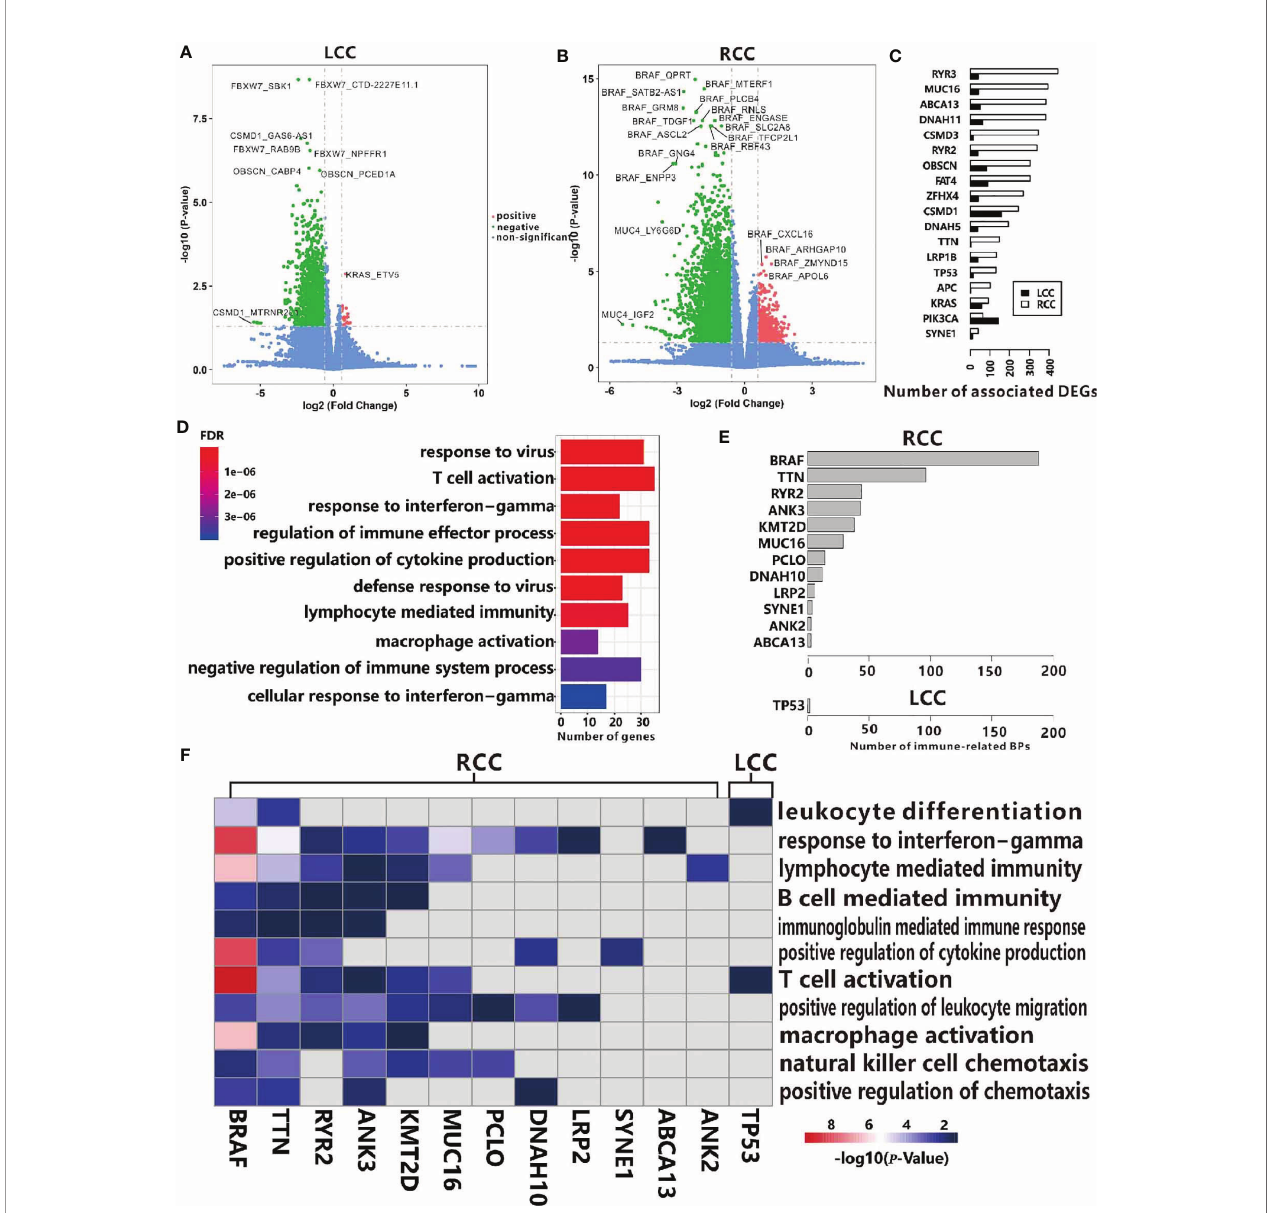
FIGURE 4 | Associations between TMGs and DEGs in RCC (A) and LCC (B) . (C) The number of associated DEGs of the 18 common TMGs in RCC and LCC. (D) GO functional enrichment analysis of TMG-upregulating DEGs in RCC. (E) The number of immune-related BP in the up-regulated genes for each TMG in RCC and LCC. (F) The heatmap showing the -log10( P -values) of immune-related BP. The color strength represents the -log10( P -values) of associations, the grey cells represent insigni fi cant associations in RCC and